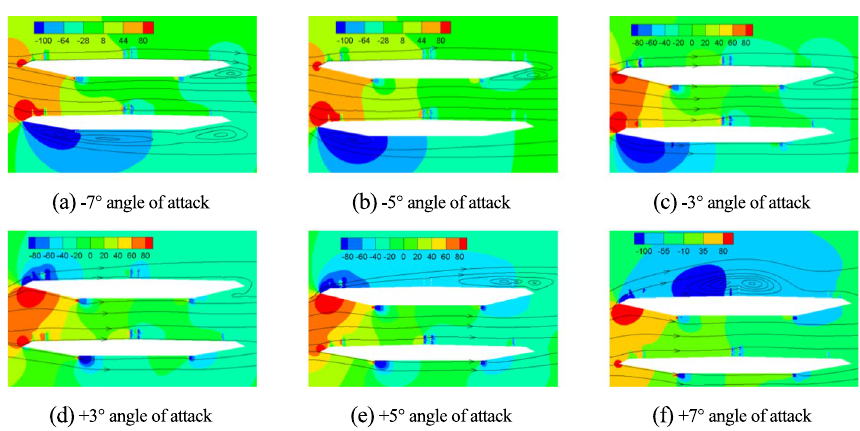
Fig. 7 Contours of the static pressure around the two boxes at different angles of